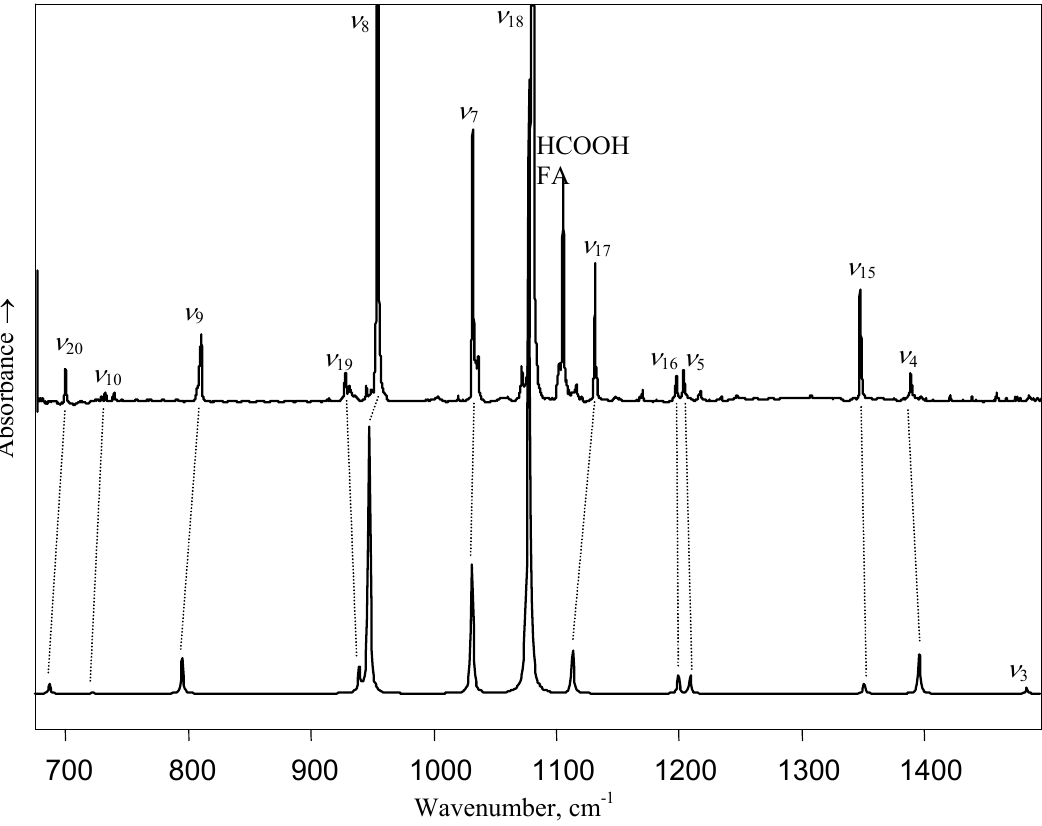
Fig. 5 Experimental (top) and ab initio at MP2/6-311+G(3df,3pd) level calculated (bot- tom) infrared absorption spectrum of ethene SOZ. Numbering of the fundamental bands is based on the